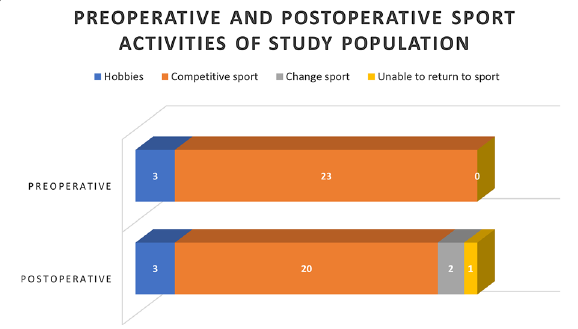
Fig. 3 Preoperative and postoperative sport activities of the study population. Reported sport activities before and after elbow arthroscopy (follow-up 60 months). Preoperatively, 23 patients practiced several kinds of sports as presented in Table 1 and only three patients practiced noncompetitive sport activities (hobbies). Postoperatively, 20 patients involved in competitive sports continued their activities, two patients changed their disciplines, and one was unable to return to sport. The three patients who